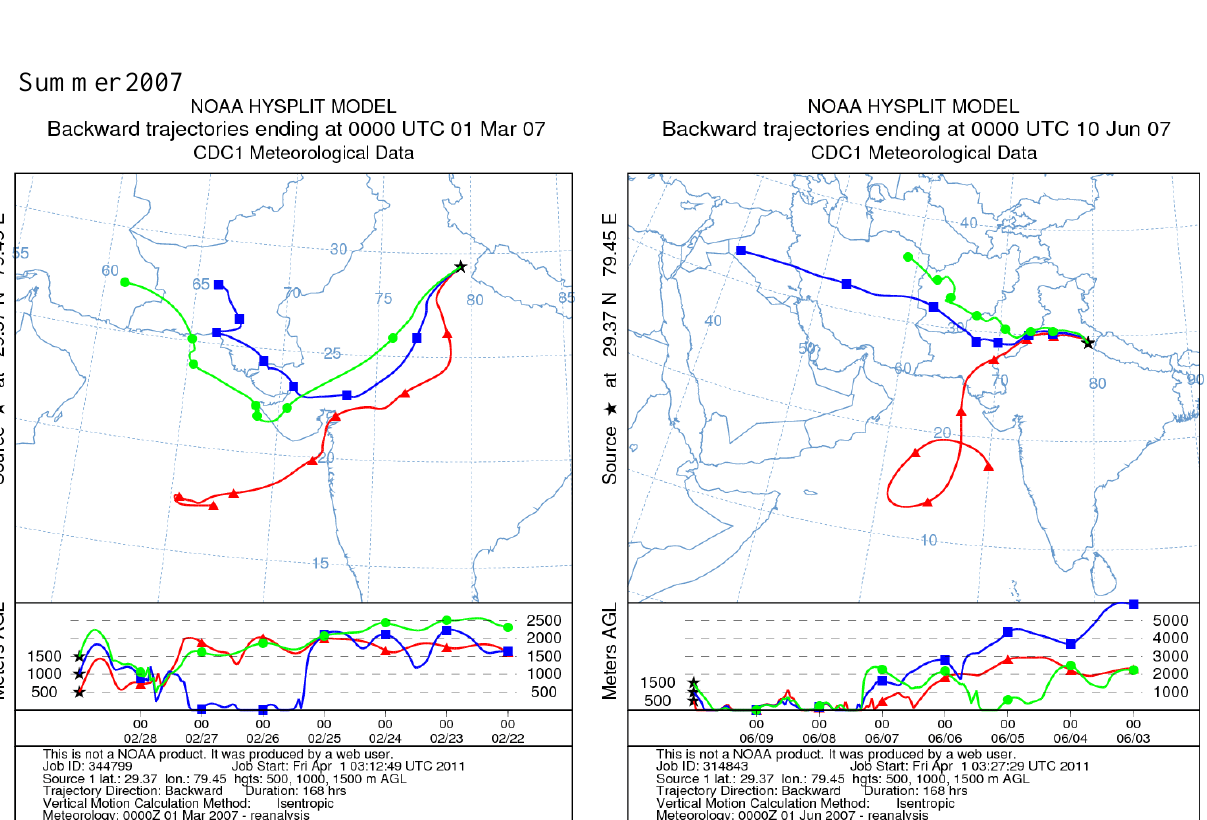
Fig. 1. Air mass backward trajectory cluster during the study period reaching Nainital (star symbol) to illustrate the long-range